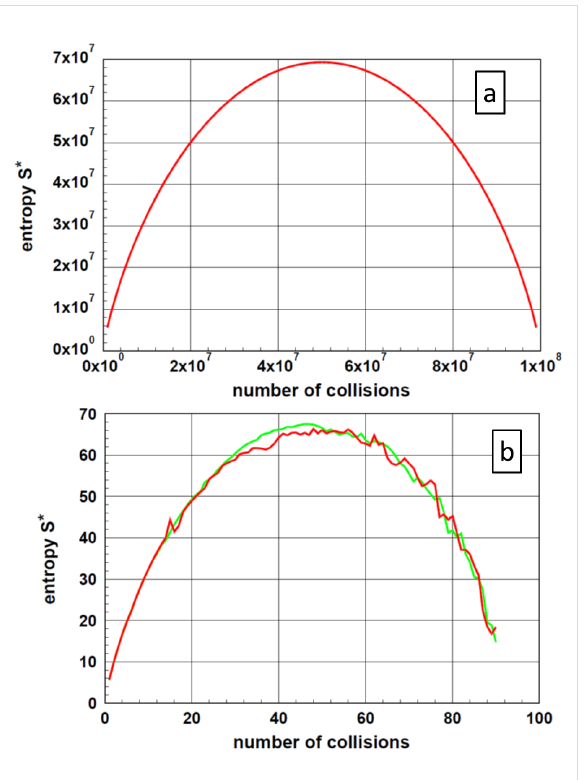
Figure 4: Entropy S * as function of the number of collisions. For this example, the starting ensemble consisted of 10 8 particles (Figure 4a). To demonstrate the fluctuations of the entropy, an additional graph of the entropy S * for two ensembles consisting of 10 2 particles is depicted (Figure 4b). In the latter case, one realizes some scatter of the entropy values. In an experiment, only fluctuations are observable after the system has reached the